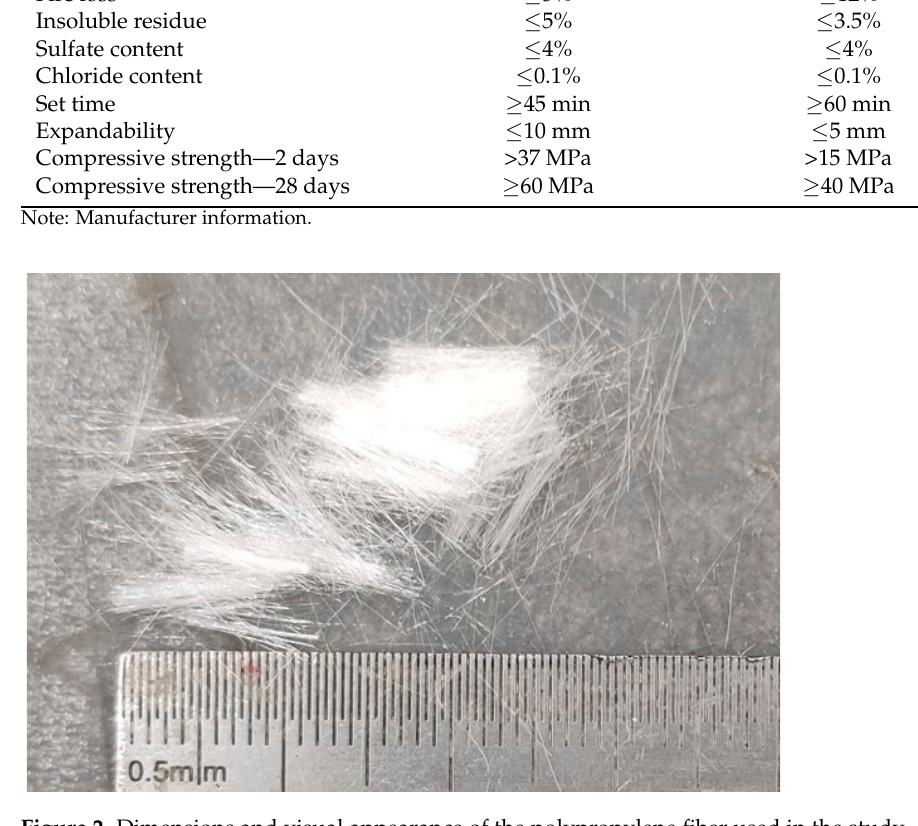
Figure 2. Dimensions and visual appearance of the polypropylene fiber used in the study.